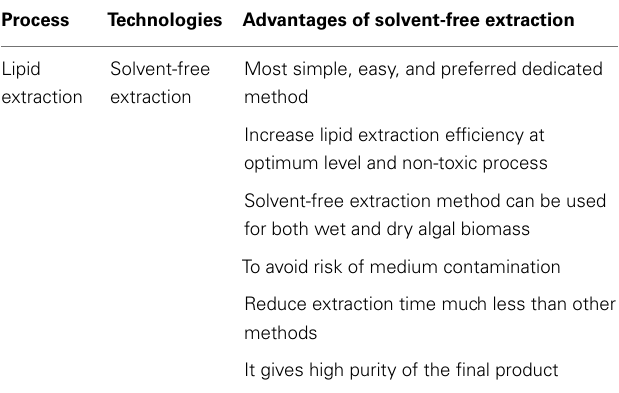
Table 1 | Selective advantages of solvent-free lipid extraction methods